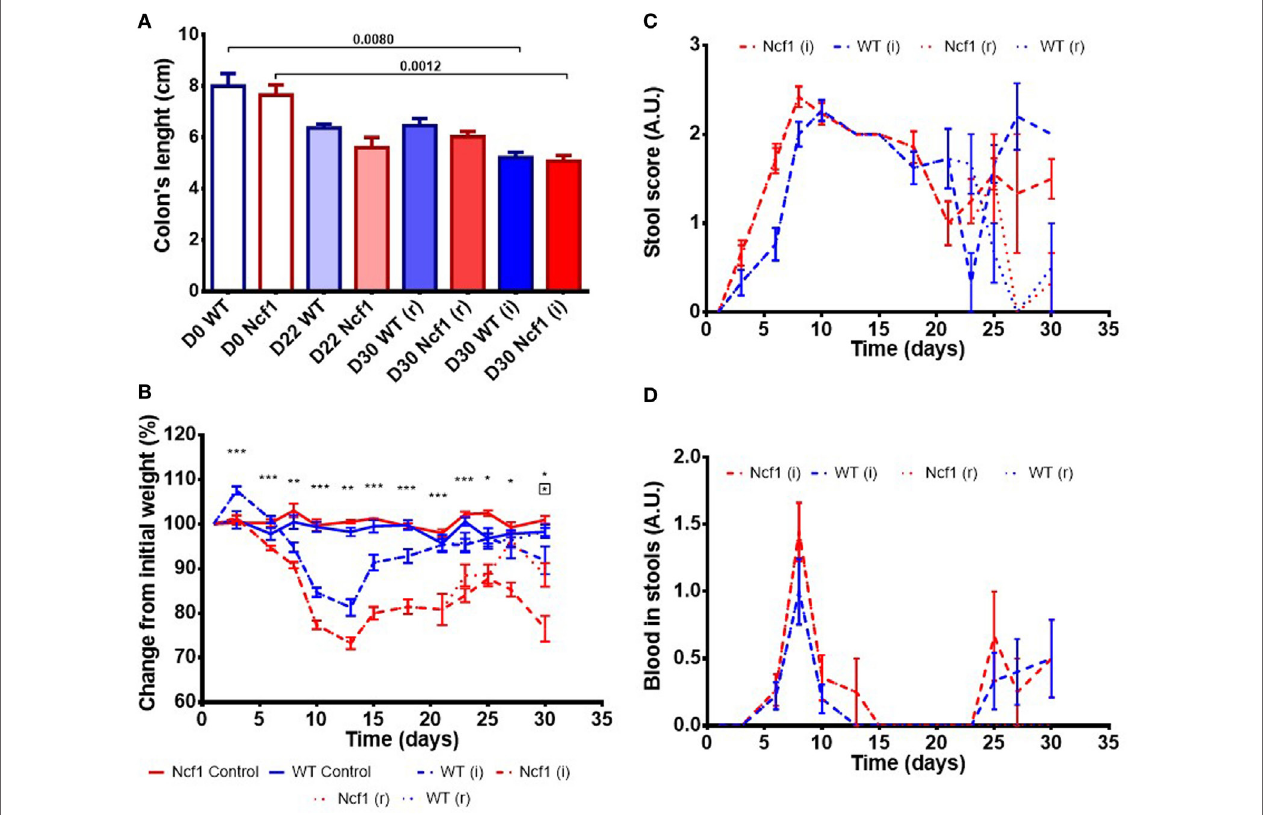
FigUre 1 | Ncf1-mutant (Ncf1) mice presented more severe clinical scores than their wild-type (WT) counterparts. (a) Colon lengths in centimeters for days 0, 22, and 30 of control, recovery (r), and twice colitis-induced (i) WT and Ncf1 groups. (B) Change in body weights from the initial average baseline weight over the experimental period, average weight ± SE (baseline weights: WT = 29.8 ± 3.90 g, Ncf1 = 31.3 ± 3.9 g). Differences between groups and time points were calculated by two-way ANOVA. (c) Mice stool consistency score after colitis induction with dextran sulfate sodium (DSS). (D) Colorectal bleeding score after colitis induction. Weight, stool consistency, and colorectal bleeding scorings are detailed in Section “Materials and Methods.”. Asterisks indicate significant differences: * p < 0.05, ** p < 0.001, *** p < 0.0001 between WT and Ncf1 mice receiving DSS; boxed asterisks indicate significant differences: * p < 0.05 between Ncf1 recovery (r) and induction (i)